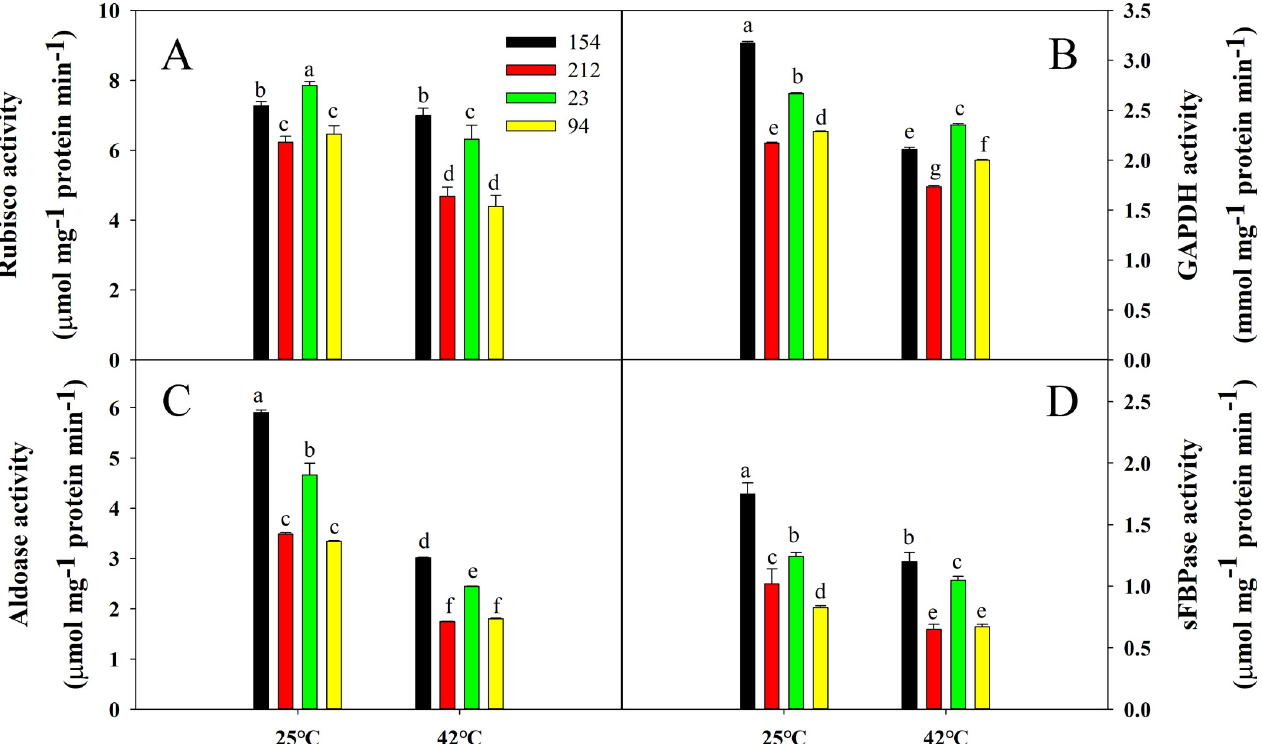
Fig 4. Effects of high temperature (treatment at 42˚C for 4 h) on the activities of key enzymes involved in the Calvin cycle of wheat leaves: (A) Rubisco, (B) GAPDH, (C) sFBPase, and (D) aldolase. Lines 154 and 23 possess high photosynthetic rates; Lines 212 and 94 possess low photosynthetic rates. The values are the mean ± SE from three independent experiments. Different letters indicate significant differences at P =